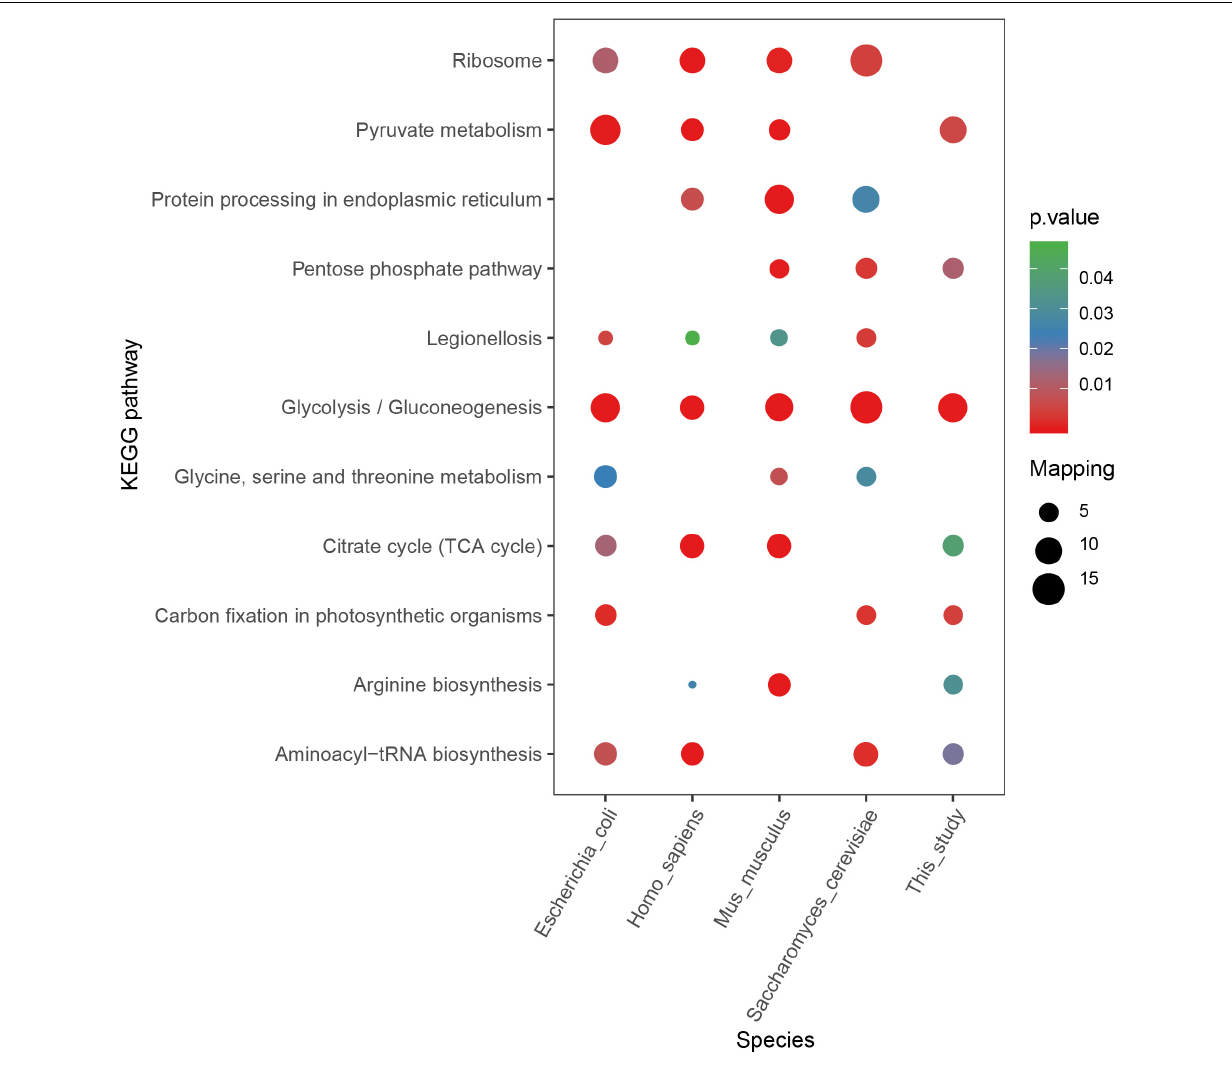
FIGURE 10 | KEGG pathway enrichment analysis of succinylated proteins with the KsuD motif among five organisms ( Escherichia coli , Homo sapiens , Mus musculus , Saccharomyces cerevisiae , and Staphylococcus epidermidis